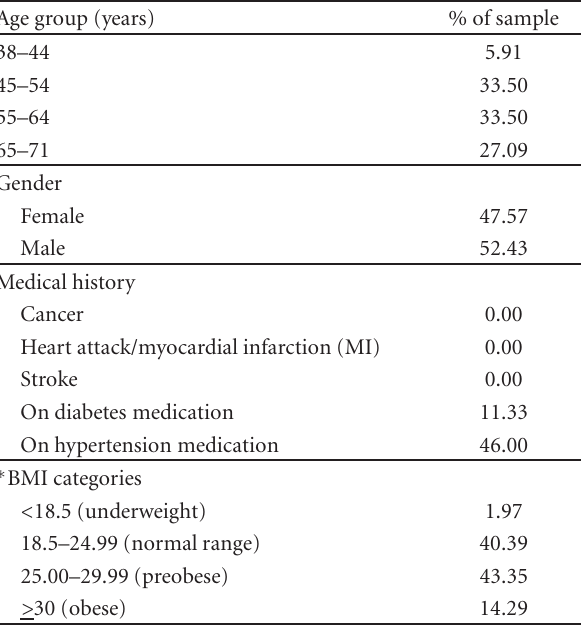
Table 2: Age, gender, medical history and body max index (BMI) ( N =